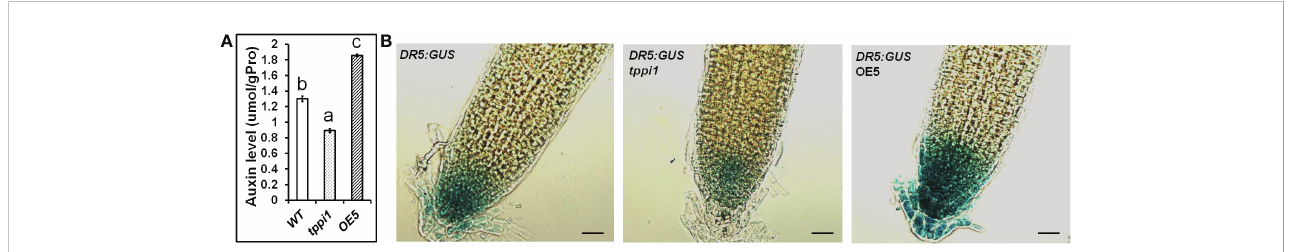
FIGURE 2 Elevated AtTPPI expression could enhance the auxin level. (A) The determination of auxin level in WT, tppi1 mutant and OE5 overexpression plants. Error bars indicate SEs (n = 3). Different lowercase letters (A – C) indicate signi fi cant differences among lines (Duncan ’ s test; p < 0.05); (B) The GUS signal of WT, tppi1 mutant and OE5 overexpression plants crossed with the DR5:GUS marker. Bar indicates 25 m m.